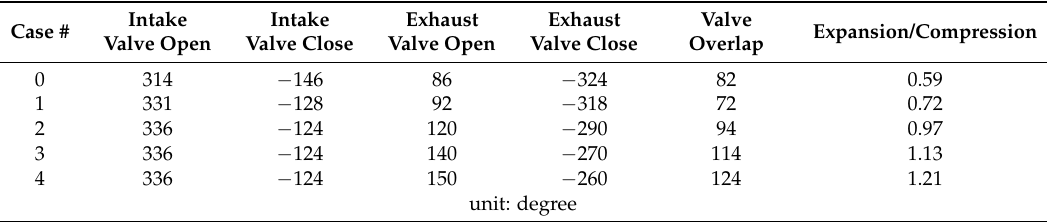
Table 5. Timing of